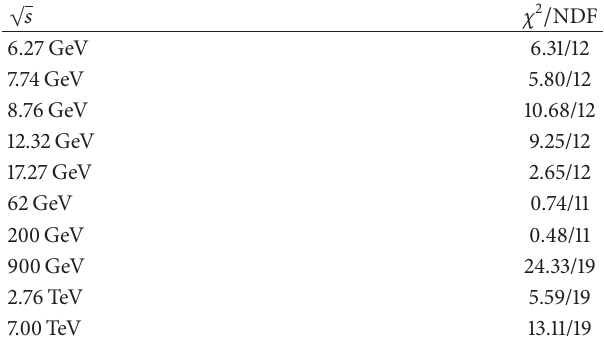
Table 2: Values of the 𝜒 2 / NDF for Tsallis fits of pion spectra at different √𝑠 .